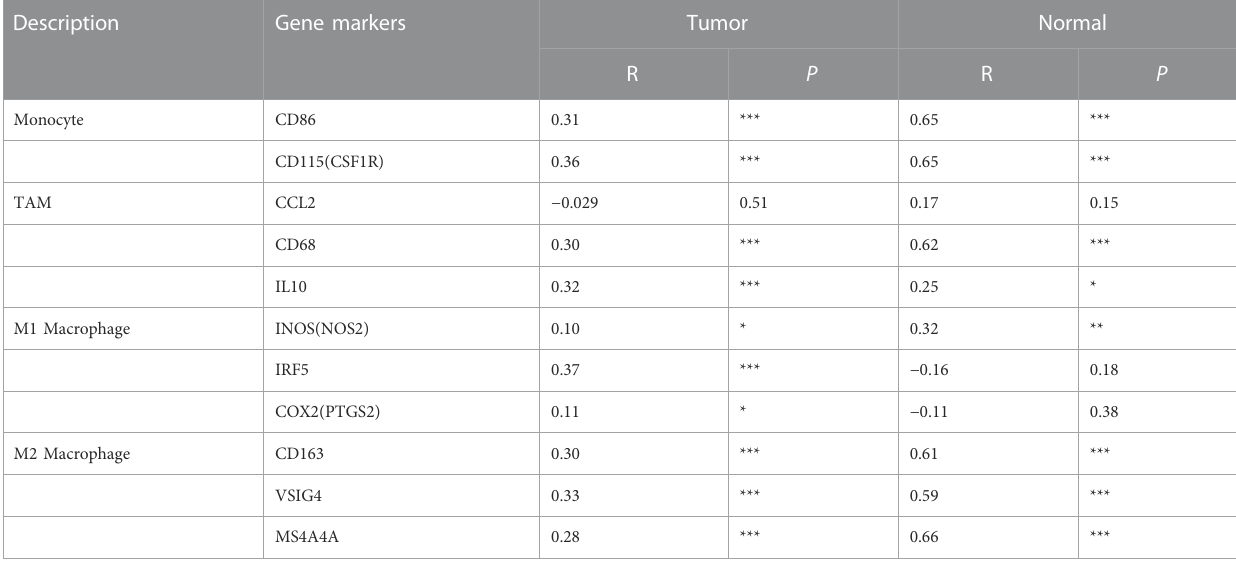
TABLE 5 Correlation analysis between GTSE1 and relate genes and markers of monocyte, TAM and macrophages in GEPIA KIRC. Description Gene markers Tumor